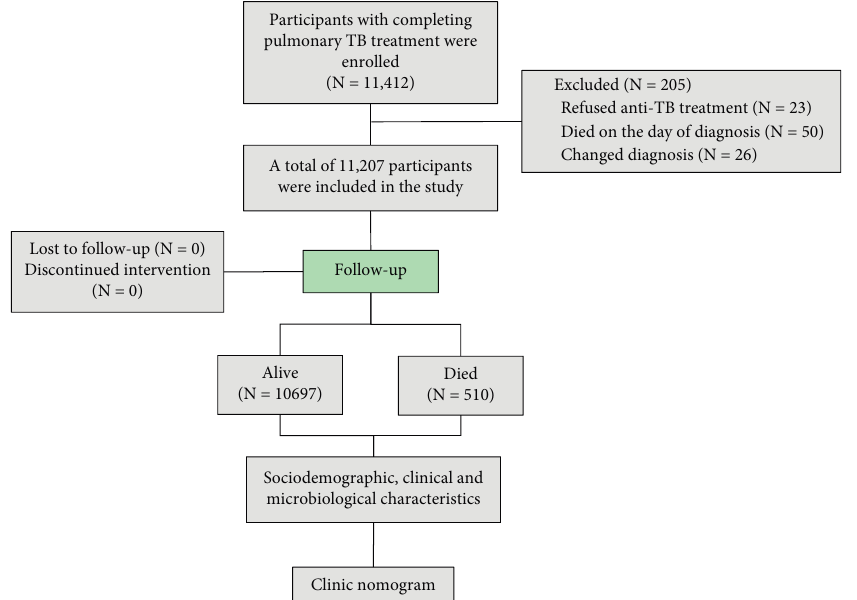
Figure 1: Flow diagram for participant inclusion and